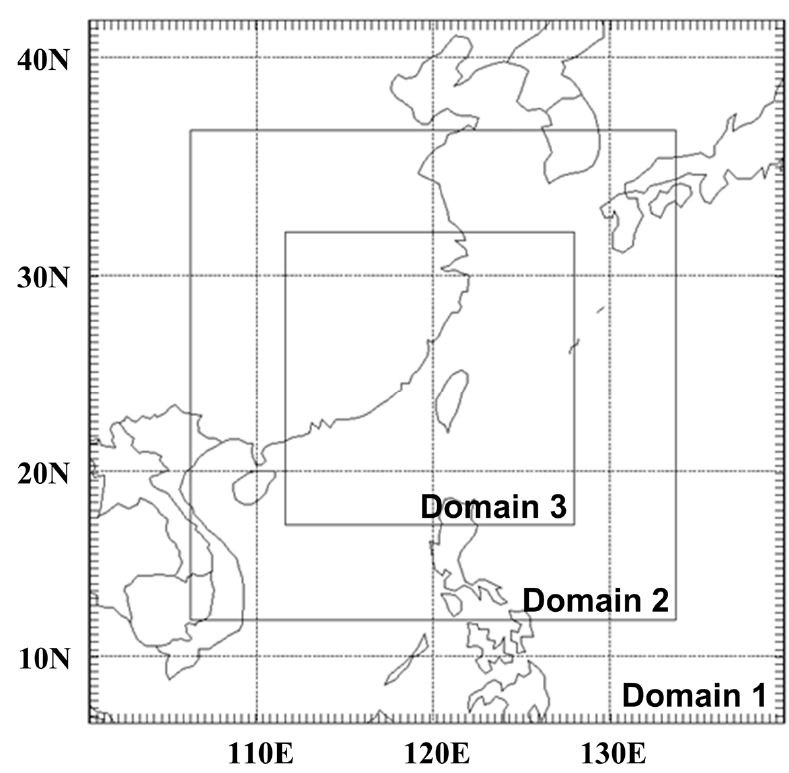
Figure 1. Nested model domain designs for WRF simulation.